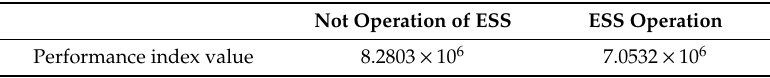
Figure 26. Comparison of the performance index for simulation results. Table 4. Comparison of the performance index of each method.